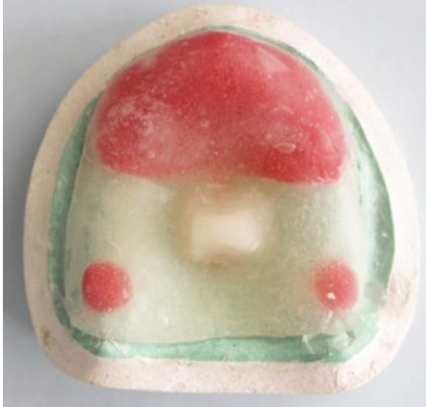
Figure 7: Maxillary custom tray with “supporting” tray covering areas of flabby tissue with the handle placed at the center of the palatal